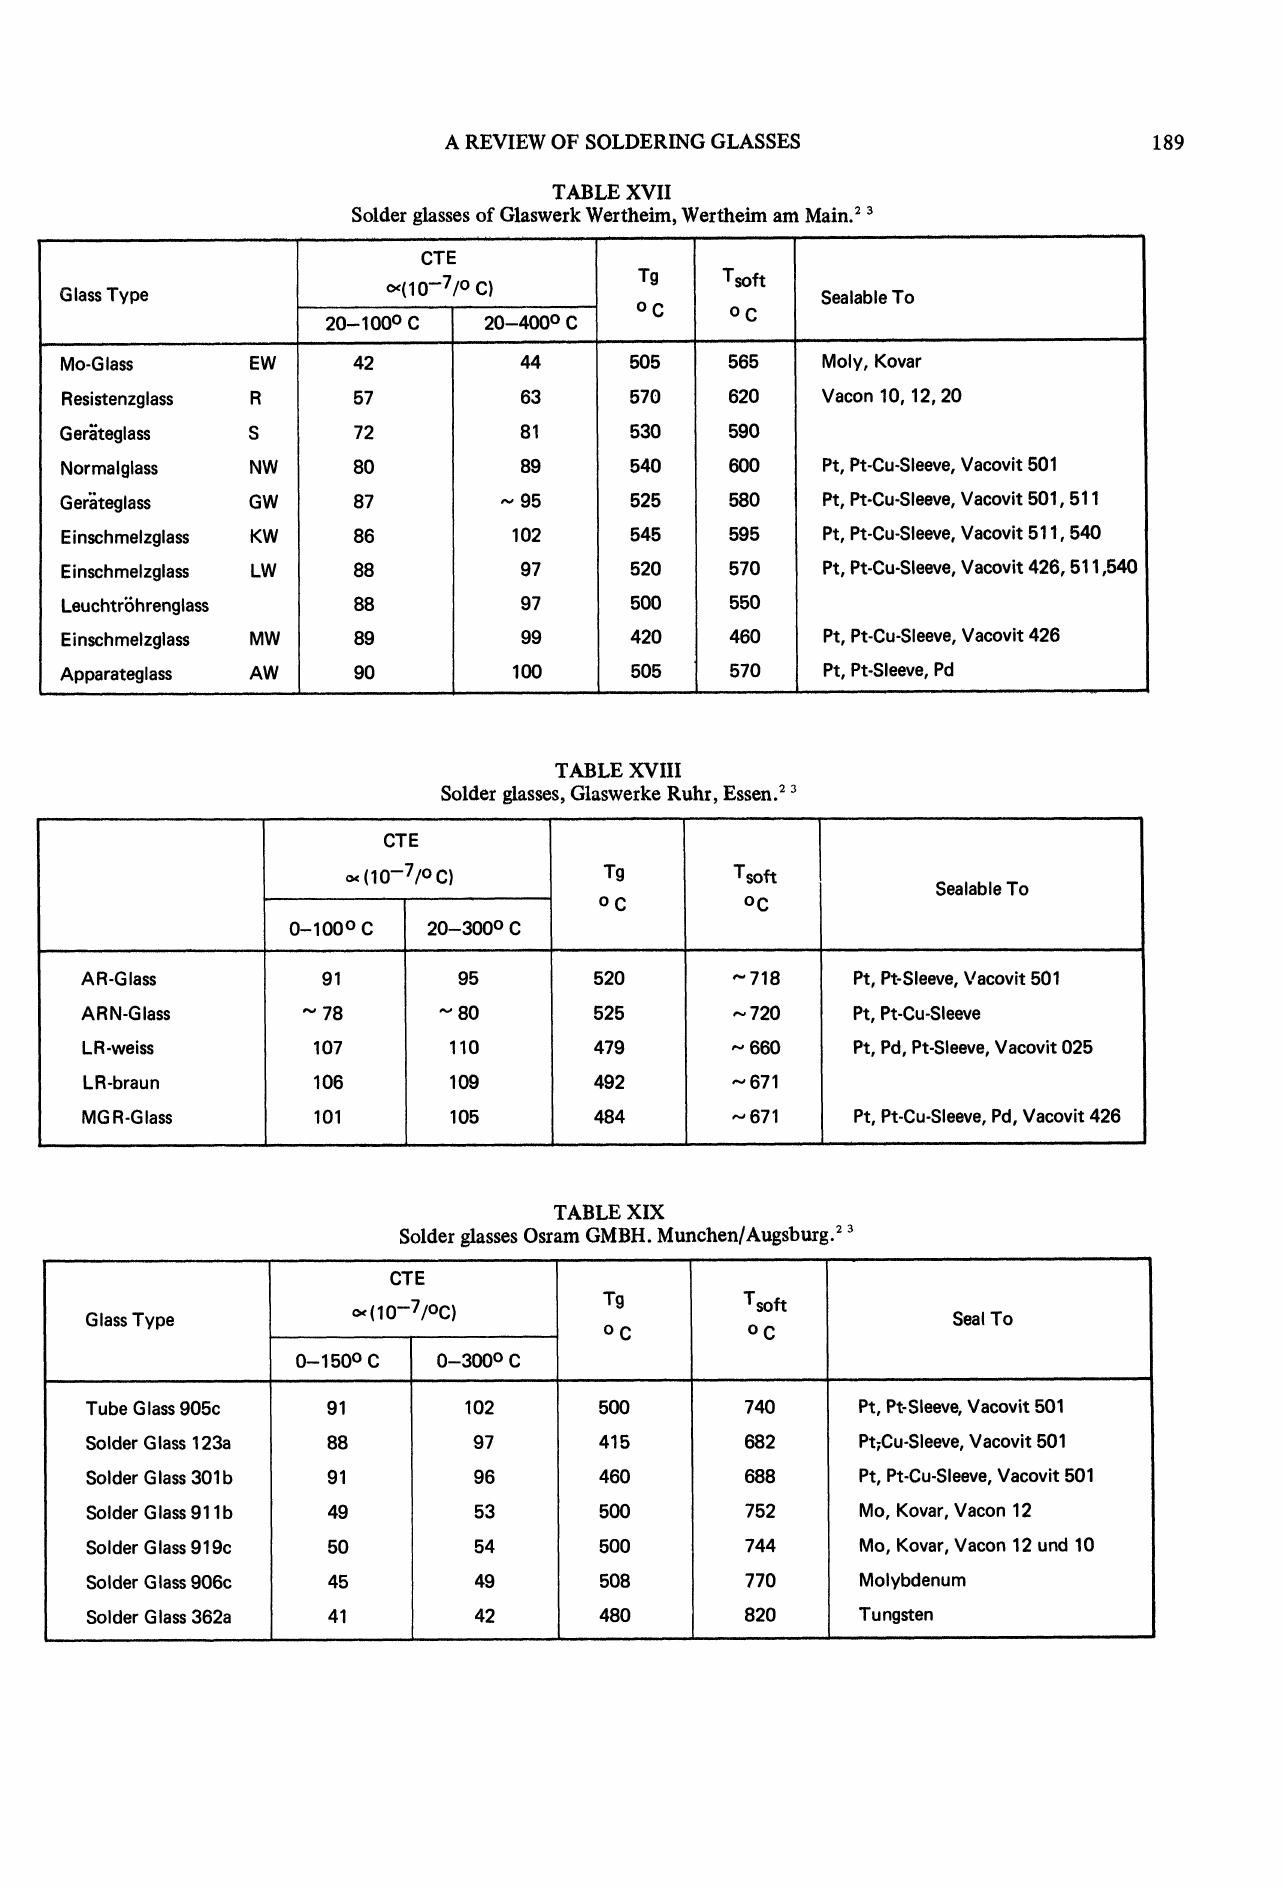
TABLE XVIII Solder #asses, Glaswerke Ruhr, Essen.